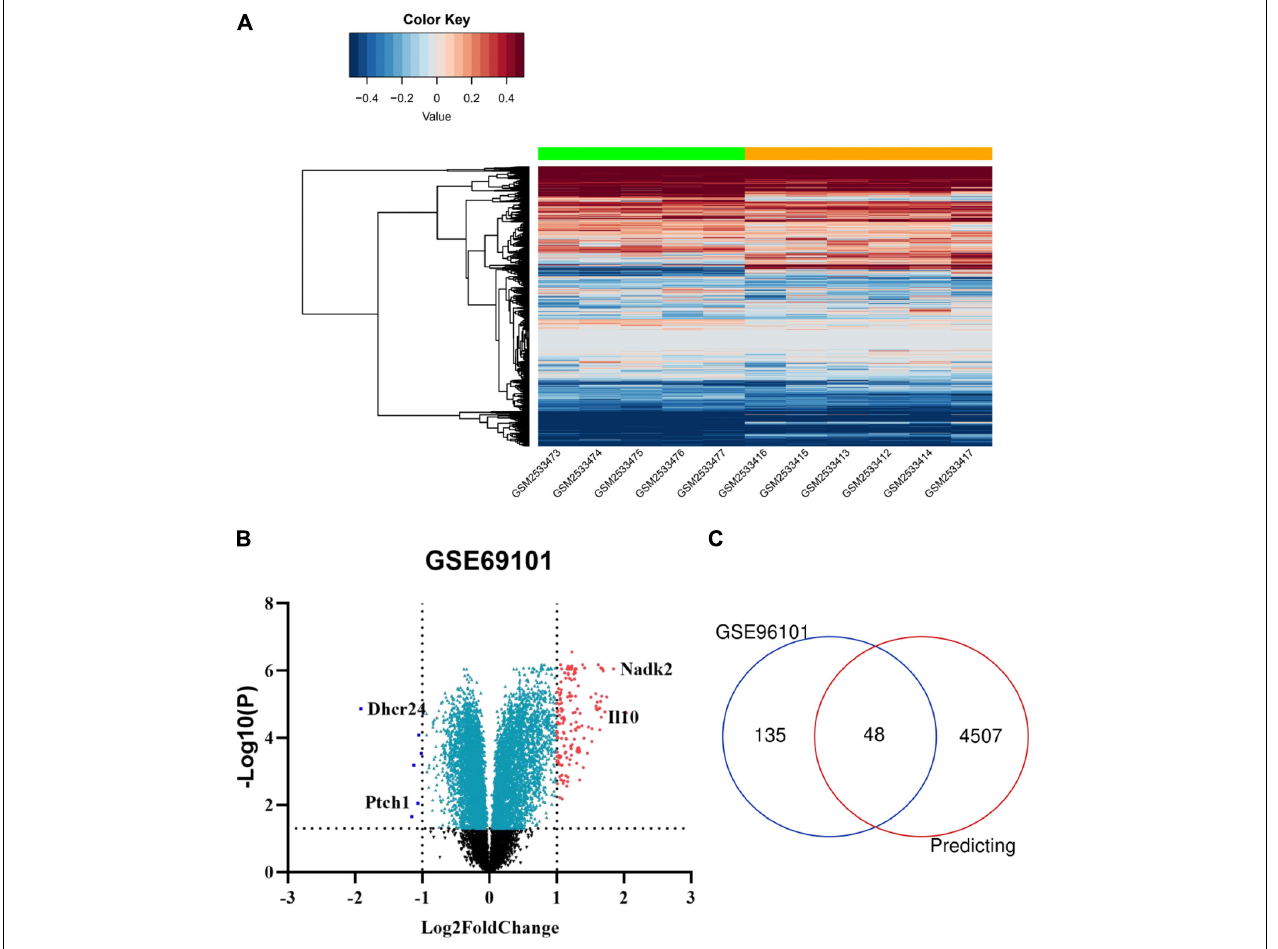
FIGURE 4 | Candidate DE-mRNAs obtained from GSE96101. (A) Heatmap showing the expression levels of each gene in different groups from GSE96101. (B) Volcano plot showing the DE-mRNAs in GSE96101. (C) Venn diagram showing 48 common DE mRNAs obtained from GSE96101 and predicted mRNAs from